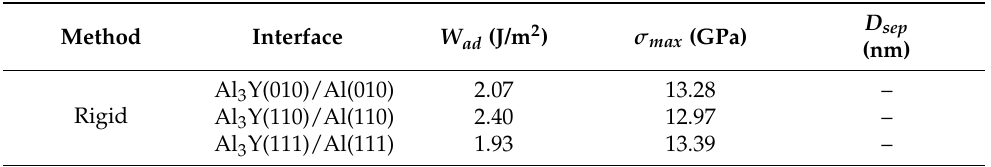
Table 4. Separation distance ( D sep ), work of adhesion ( W ad ), fracture energy ( E fra ), and maximum tensile stress ( σ max ) of the